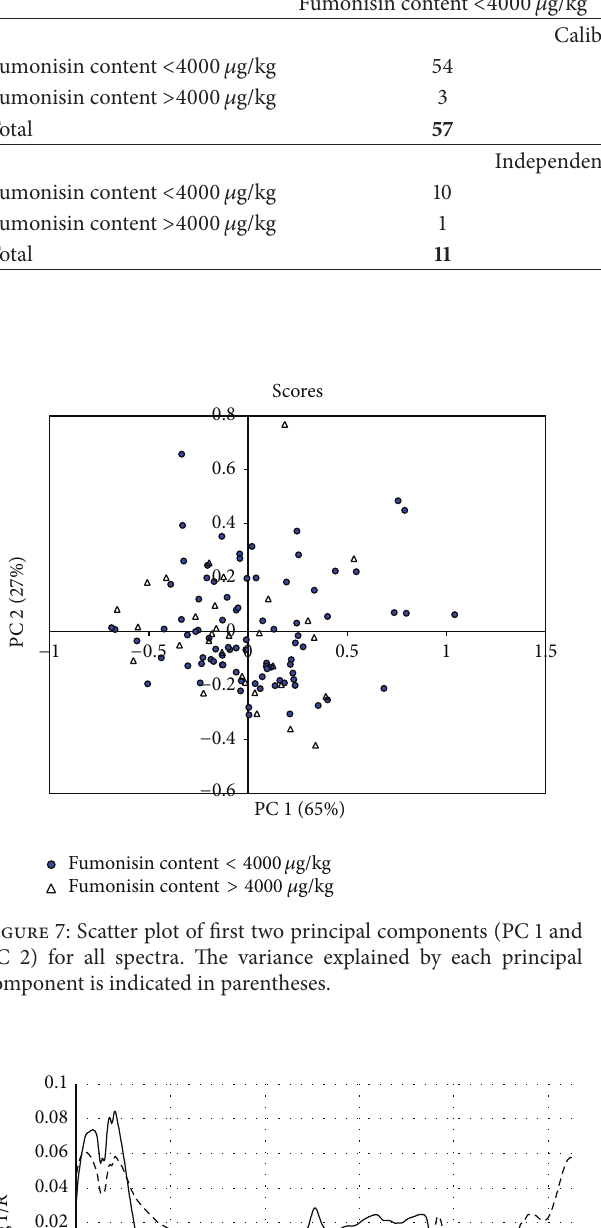
Table 5: Results of discriminant analysis based on NIRS to sort maize samples according to their risk of contamination with fumonisins. From